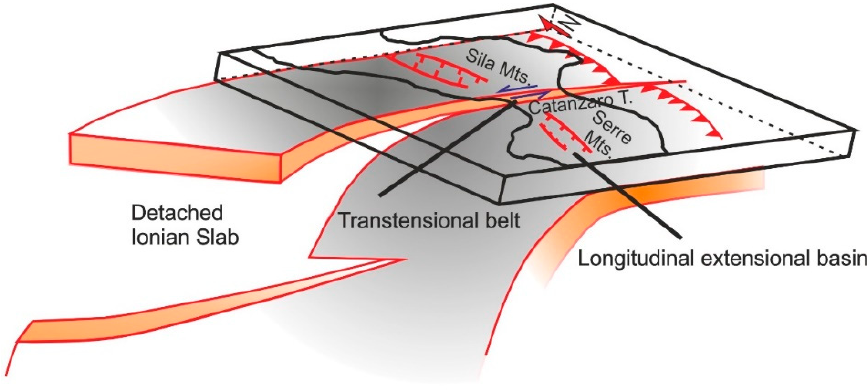
Figure 9. Geodynamic interpretation of the studied area. Detached Ionian slab depicted on the base of seismological data from Scarfì et al. [25].